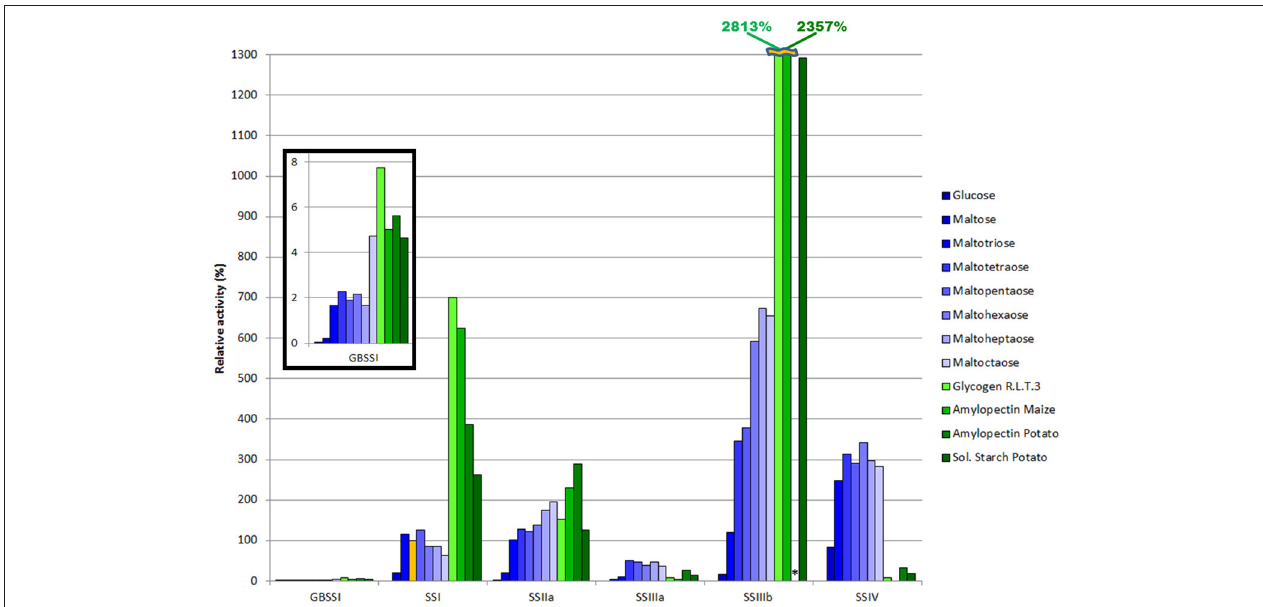
FIGURE 1 | Substrate specificity of SSs. Relative activity for all SS enzymes with different MOS and polysaccharides as acceptors, assayed at 37 ◦ C with 1mM ADP-Glc, 10mM acceptor for MOS (eight blue bars, from darker for DP = 1 to lighter for DP = 8) and 1mg/mL acceptor for branched polysaccharides (four green bars). All specific activities are normalized to the values with maltotetraose for SSI (orange bar), which corresponds to 0.302 µ mol · min − 1 · mg − 1 . Two values that would require the y-axis scale to be doubled are shown numerically with broken bars. The asterisk denotes a value which was not